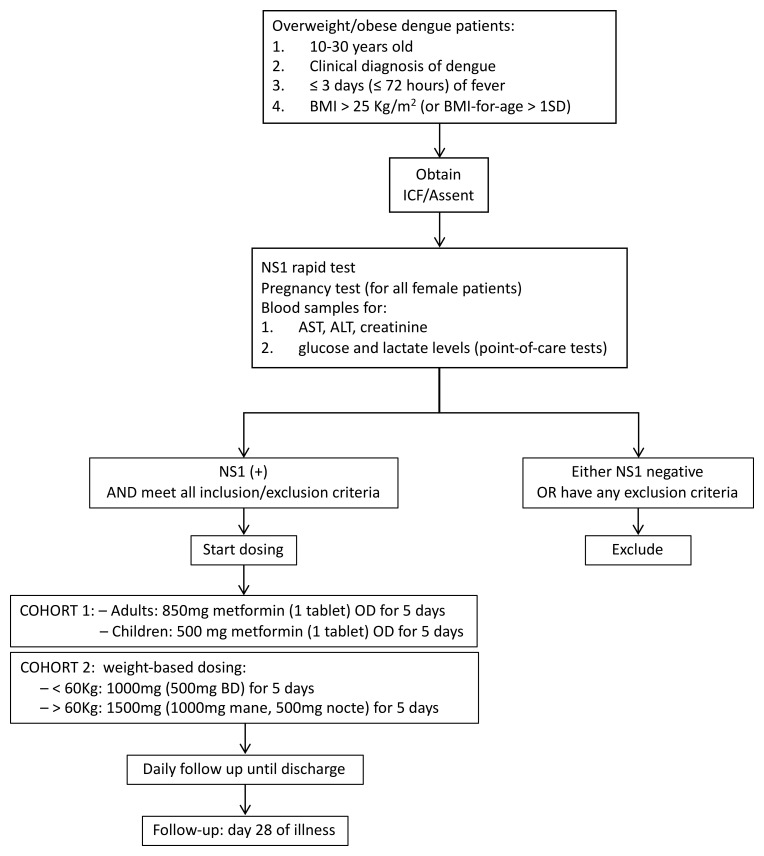
Trial flow chart.